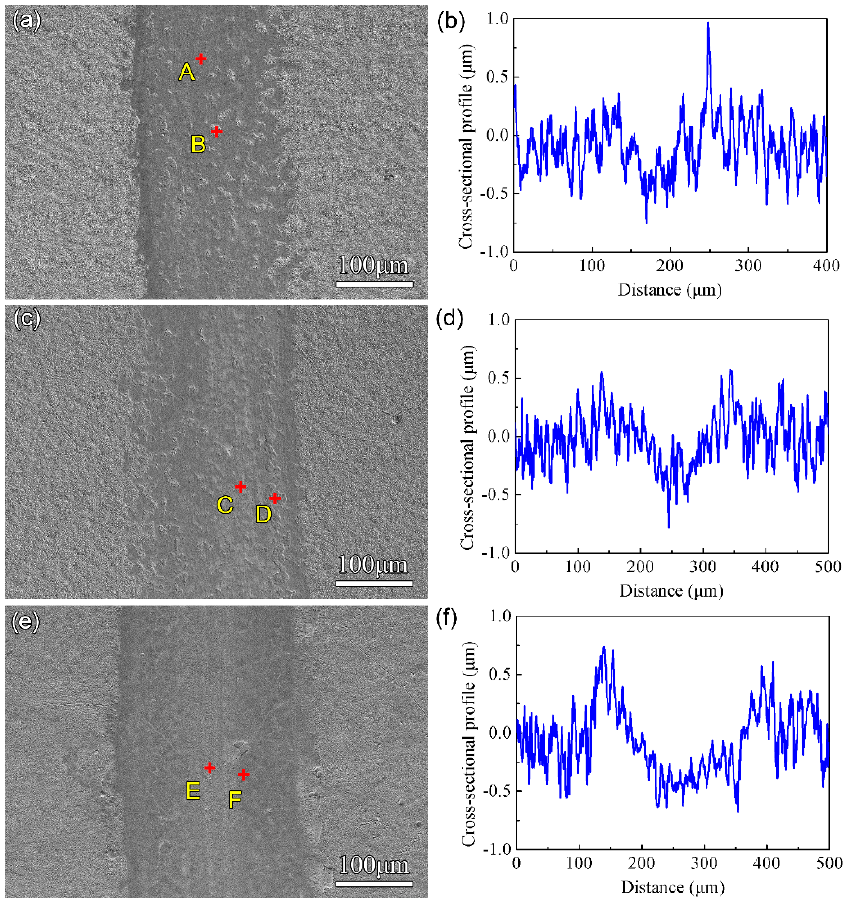
Figure 14. SEM micrographs and the cross-sectional profile of the worn track on C17200 copper alloy after plasma nitriding at 650 °C for 4 h: ( a ) and ( b ) for F1 film; ( c ) and ( d ) for F2 film; ( e ) and ( f ) for F3 film.